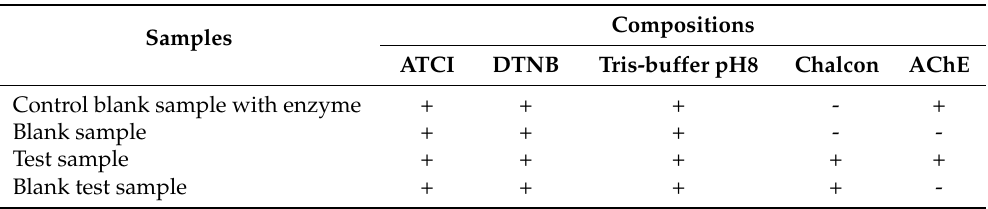
Table 1. Compositions of sample